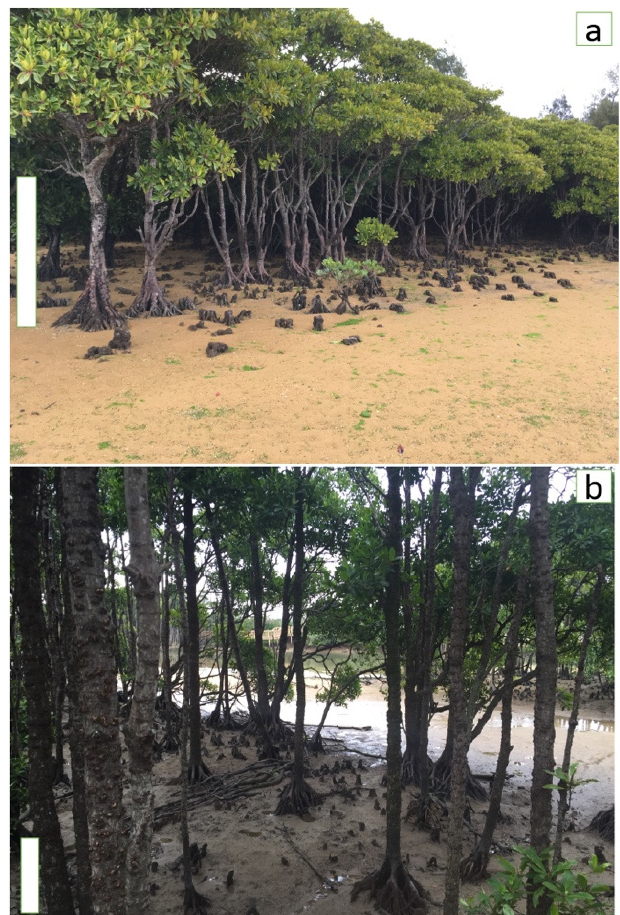
Figure 1. B. gymnorhiza trees in the oceanside population ( a ), and the riverside population ( b ). Bars represent about one meter. Oceanside trees appear shorter (1–1.5 m) and the riverside trees grow to be tall at about 7–8 m.